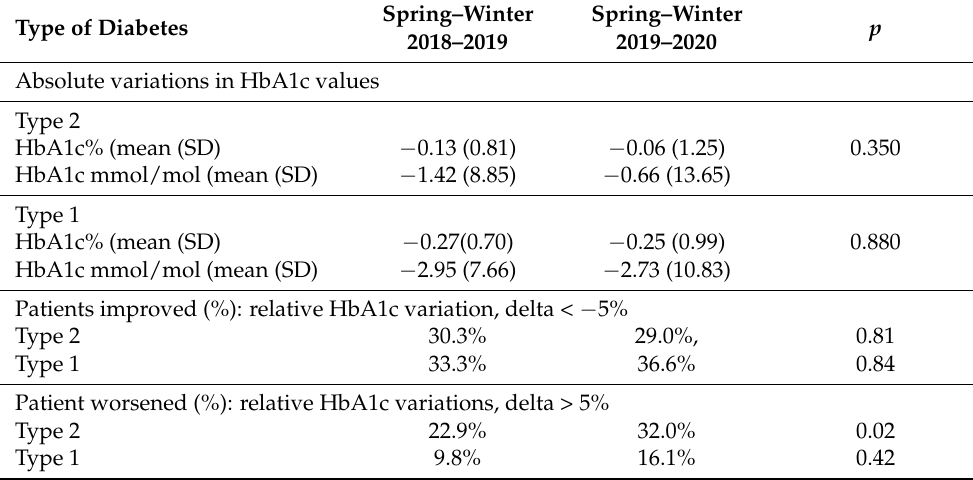
Table 3. Summary of the main results: changes in HbA1c values during the observation